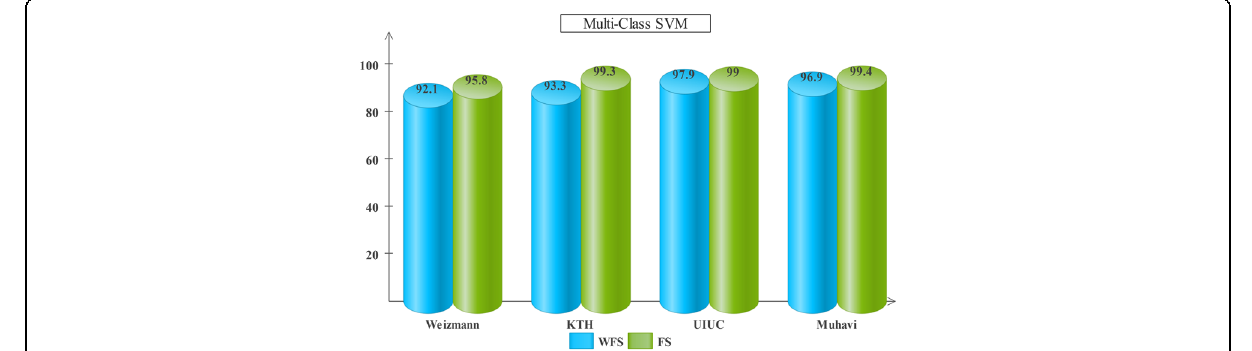
Fig. 12 Comparison of proposed feature selection method with WFS